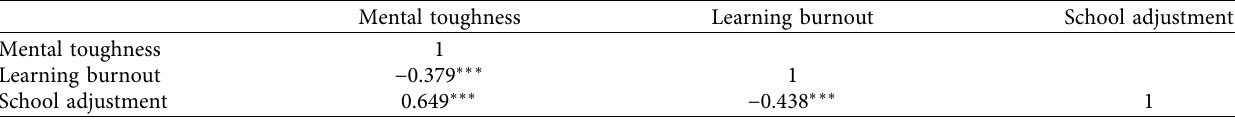
Table 6: Correlation coefficients.